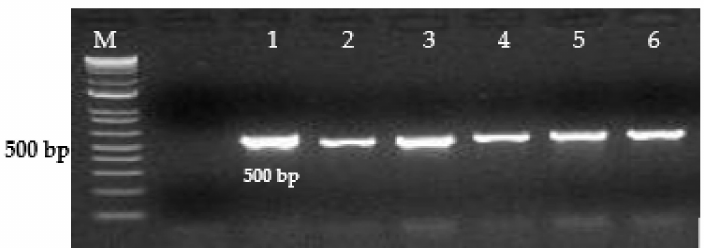
Figure 1. Detection of S. enterica using PCR primers SE Inv-1F and SE Inv-1R (500 bp). Lane M—1kb ladder (Invitrogen). Lane 1—PCR products amplified from S. Enteritidis ( S. e-0071), lane 2—PCR products amplified from S. Typhimurium TA 98, reference strain, lane 3—PCR products amplified from S. Virchow, reference strain, lanes 4, 5, 6—clinical samples, positive for S. enterica.